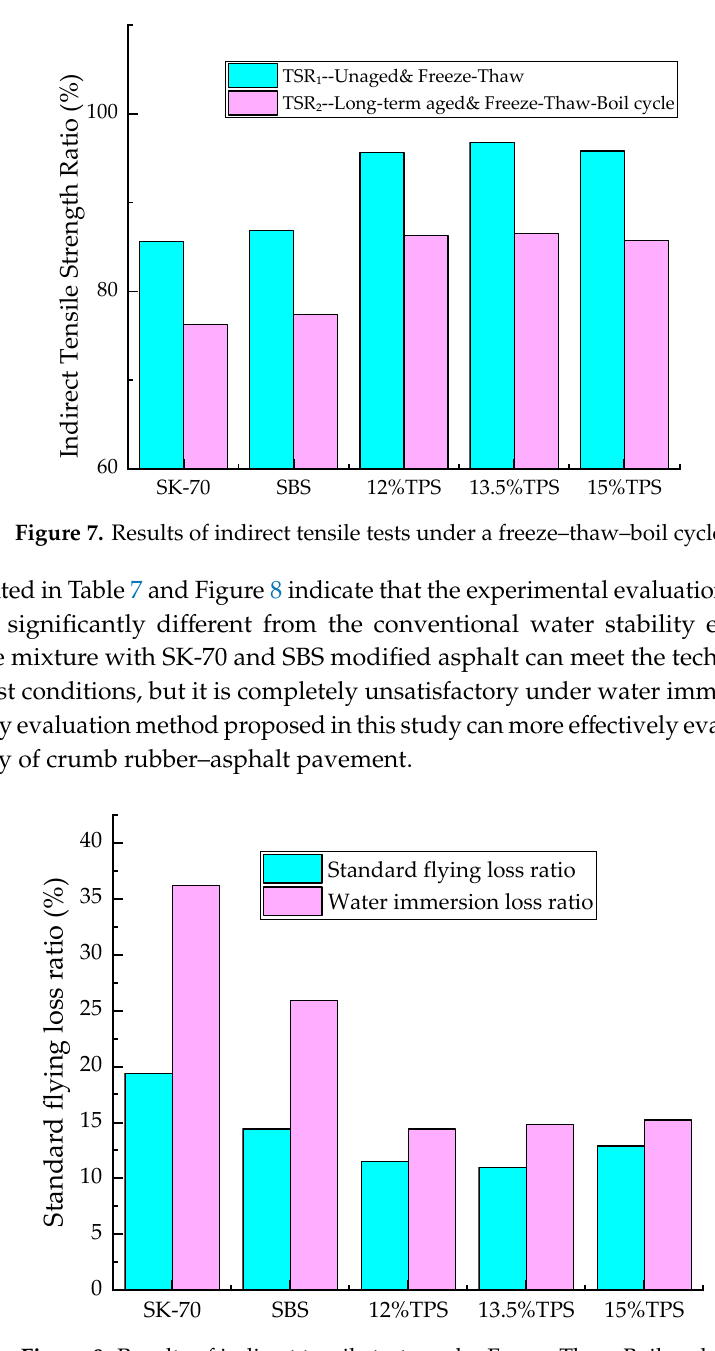
Figure 8. Results of indirect tensile tests under Freeze-Thaw-Boil cycle.